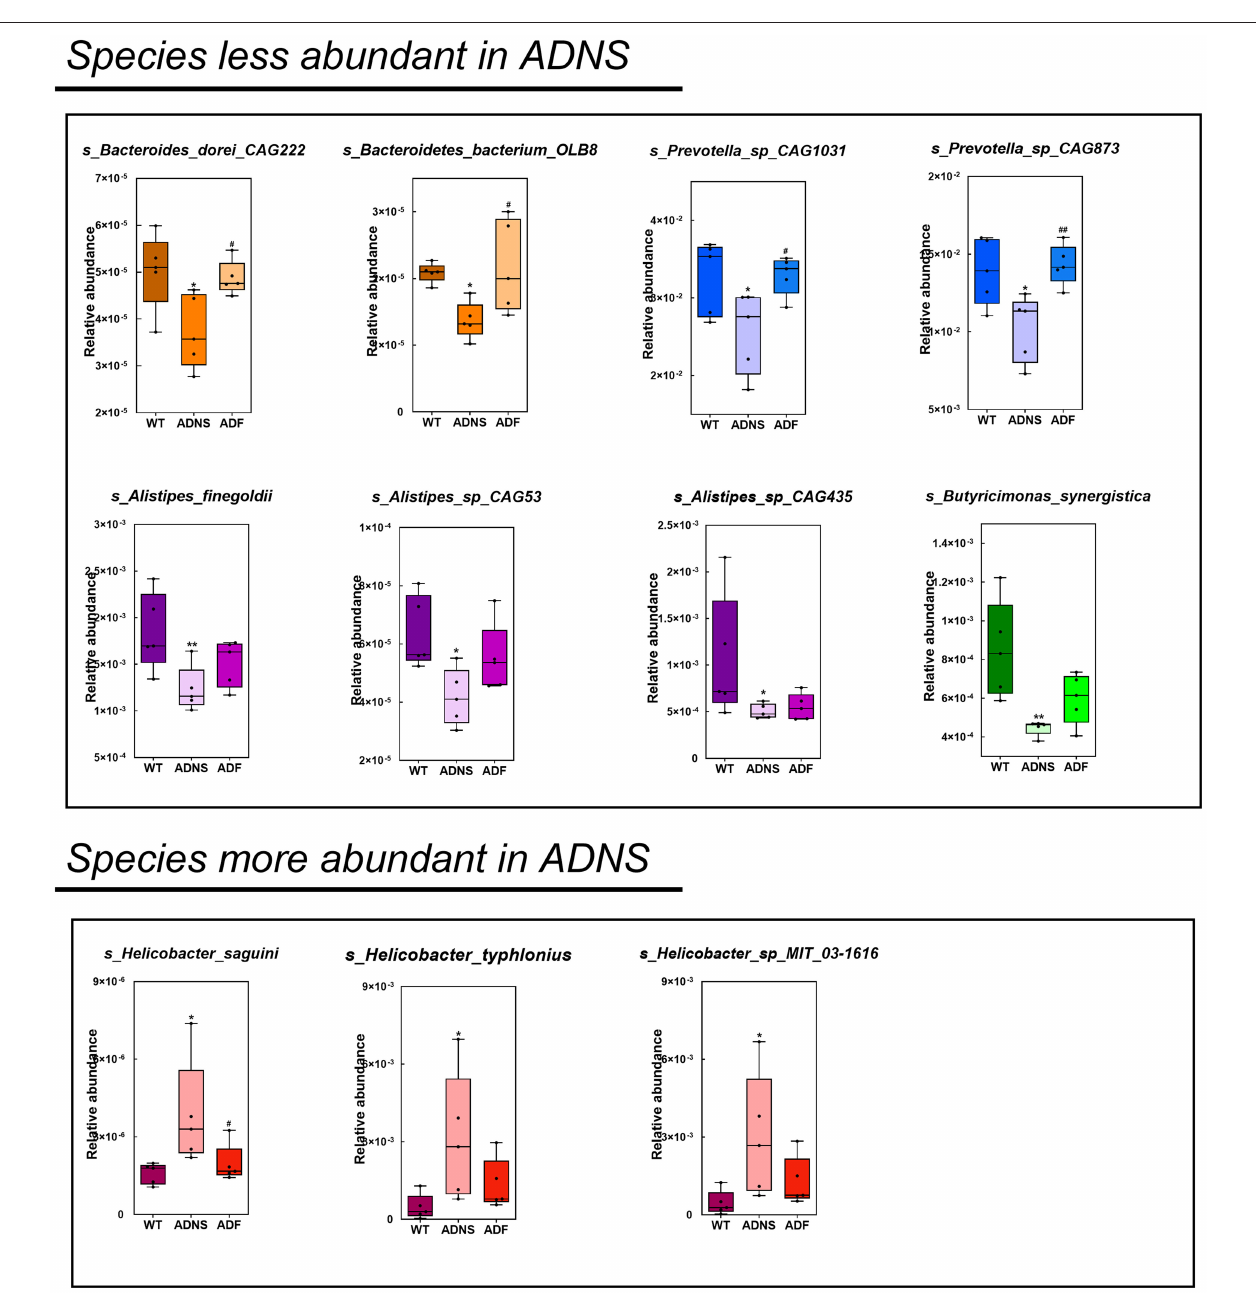
FIGURE 4 | Comparison of bacterial species in WT, ADNS and ADF mice. Each box plot represents the median, interquartile range, minimum, and maximum values for the relative abundance of individual species. Species with less abundant in ADNS compared to WT ( p < 0.05), which was reversed in ADF, included (upper): s_Bacteroides_dorei_CAG222 ( p < 0.05), s_Bacteroidetes_bacterium_OLB8 ( p < 0.05) (both in orange), s_Prevotella_sp_CAG1031 ( p < 0.05), and s_Prevotella_sp_CAG873 ( p < 0.01) (both in blue). Species with less abundant in ADNS compared to WT, which was not significantly blocked in ADF, included (middle): s_Alistipes_finegoldii ( p < 0.01), s_Alistipes_sp_CAG53 ( p < 0.05), s_Alistipes_sp_CAG435 ( p < 0.05) (all in purple), and s_Butyricimonas_synergistica ( p < 0.01; in green). Species with more abundant in ADNS compared to WT ( p < 0.05), which was significantly blocked in ADF, included (lower left) s_Helicobacter_saguini ( p < 0.05; in pink); species with increased abundance in ADNS relative to WT ( p < 0.05), which was not significantly attenuated in ADF, included (lower middle and right) g_Helicobacter ( s_Helicobacter_typhlonius and s_Helicobacter_sp_MIT_03-1616 ); n = 5. * p < 0.05, ** p < 0.01 vs. WT; # p < 0.05, ## p < 0.01 vs. ADNS.